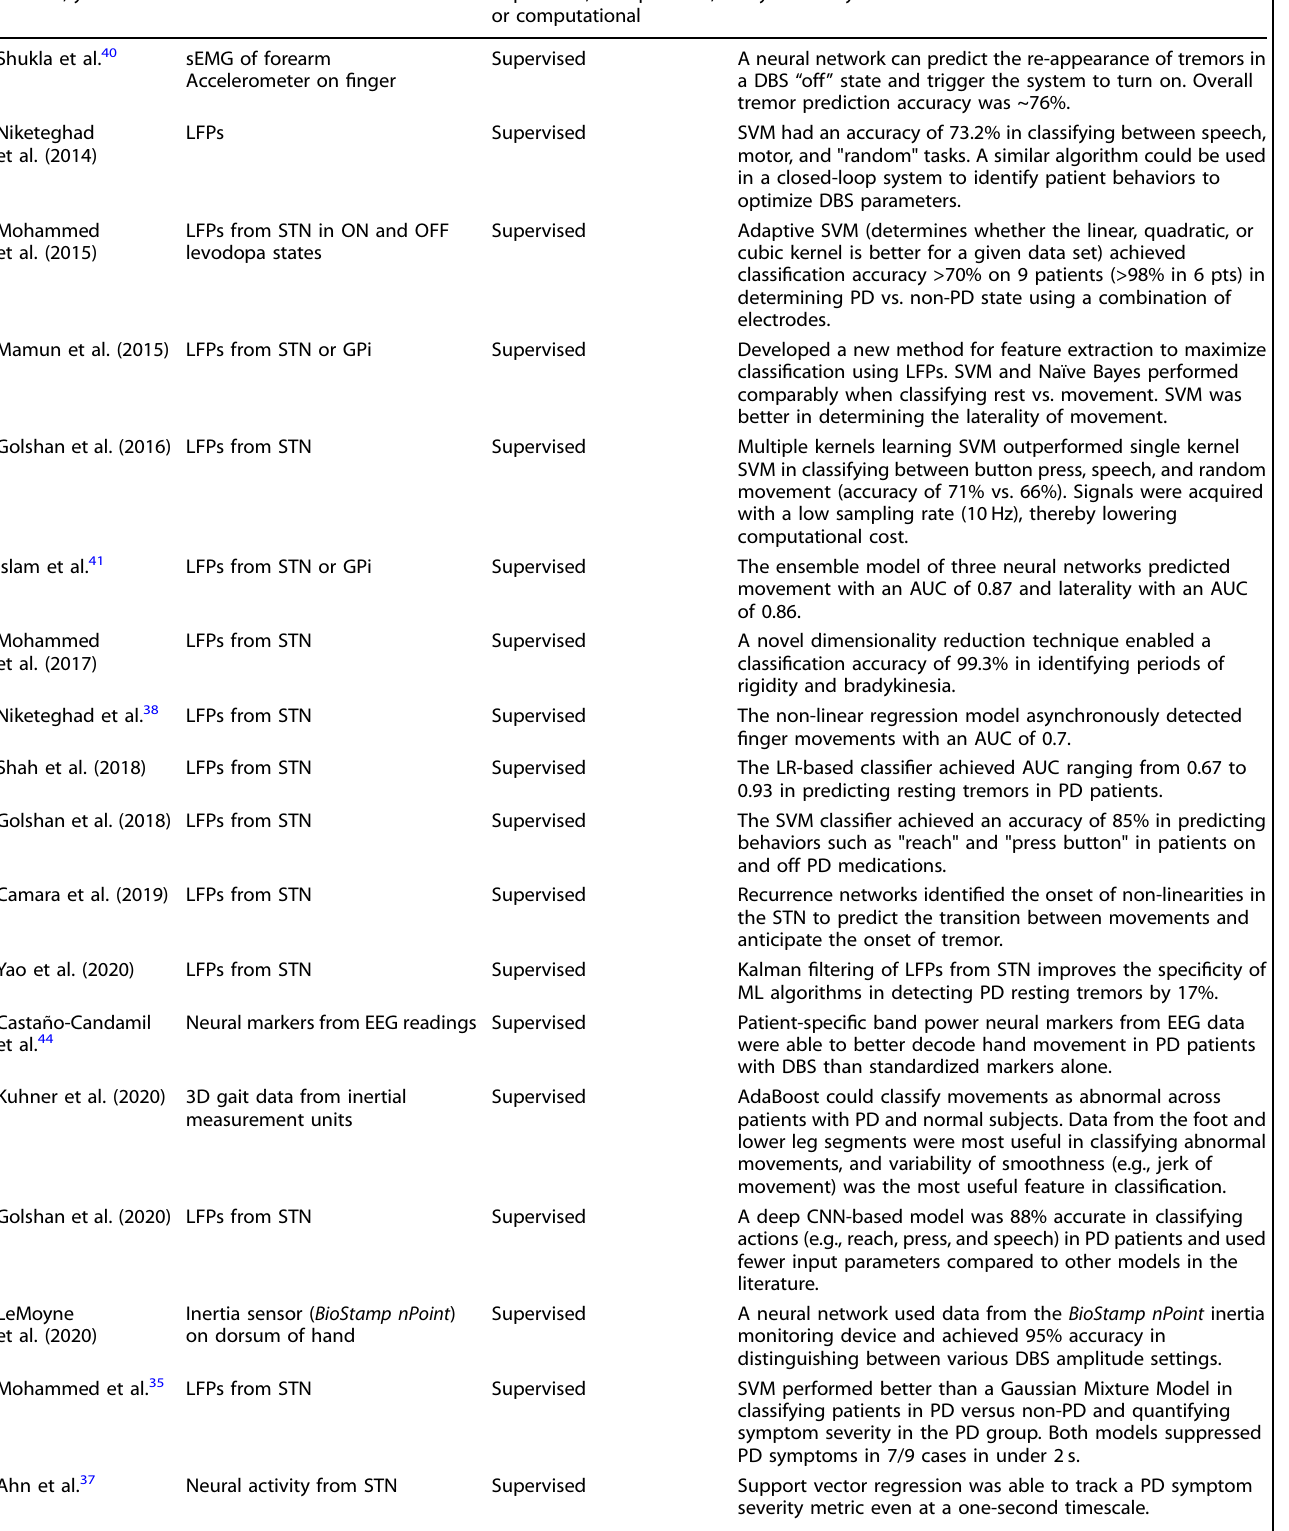
Table 3. Studies assessing use of ML to develop closed-loop systems for PD. Multiple ML algorithms have been leveraged and have primarily used LFPs from STN as the data source. Some solutions combine BStim systems with wearables, but most leverage BStim data